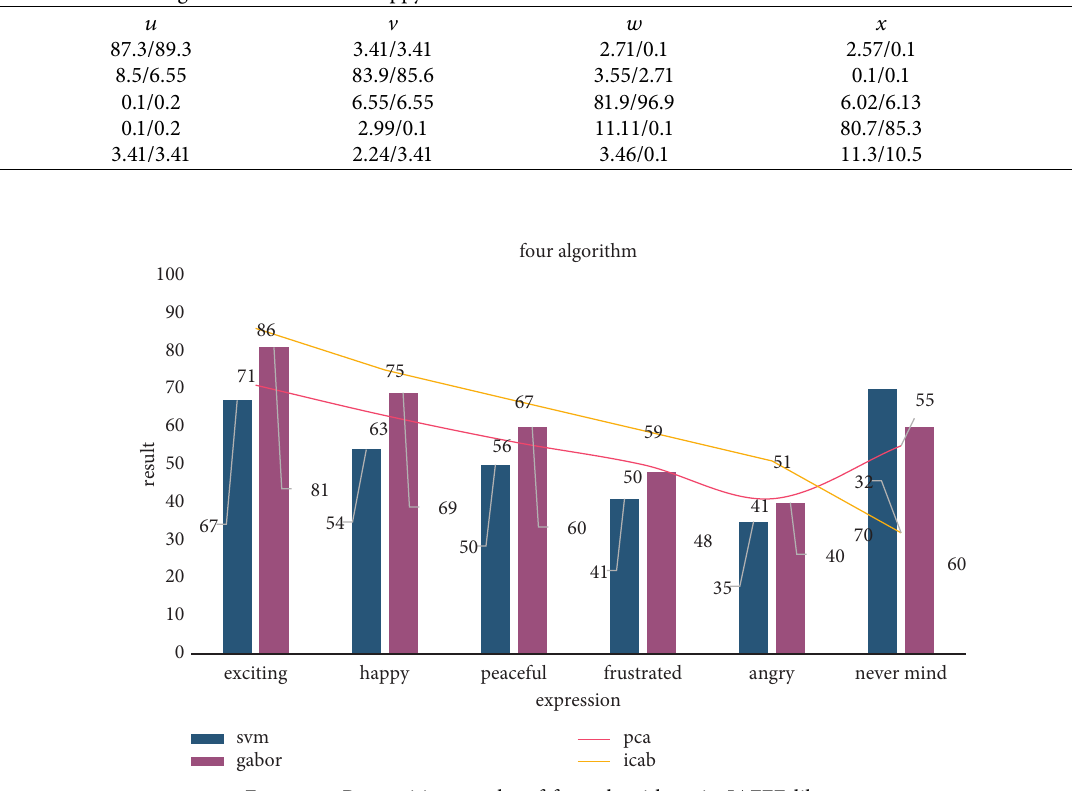
Figure 5: Recognition results of four algorithms in JAFFE library.